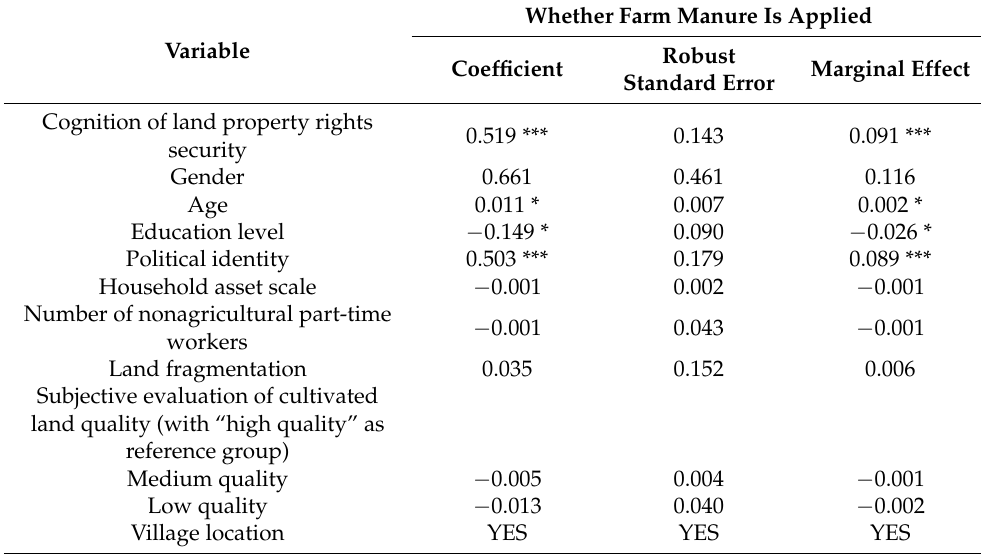
Table 2. Cognition of land property rights security and farmers’ cultivated land quality protection behavior.